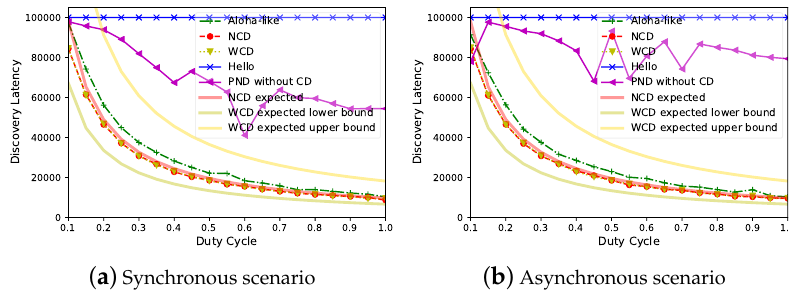
Figure 8. Panacea has better tradeoff between duty cycle and latency for both synchronous and asynchronous